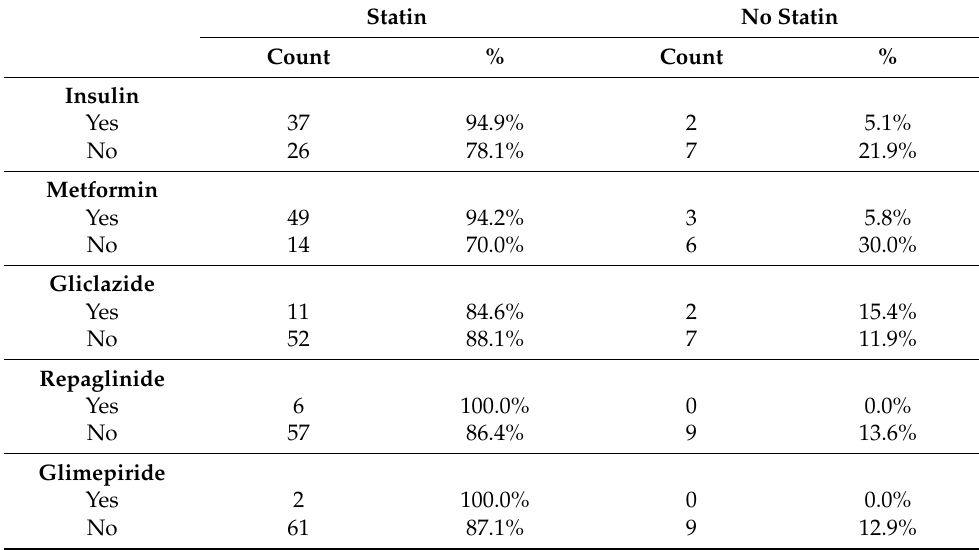
Table 2. Different management of type 2 diabetes mellitus patients in the study